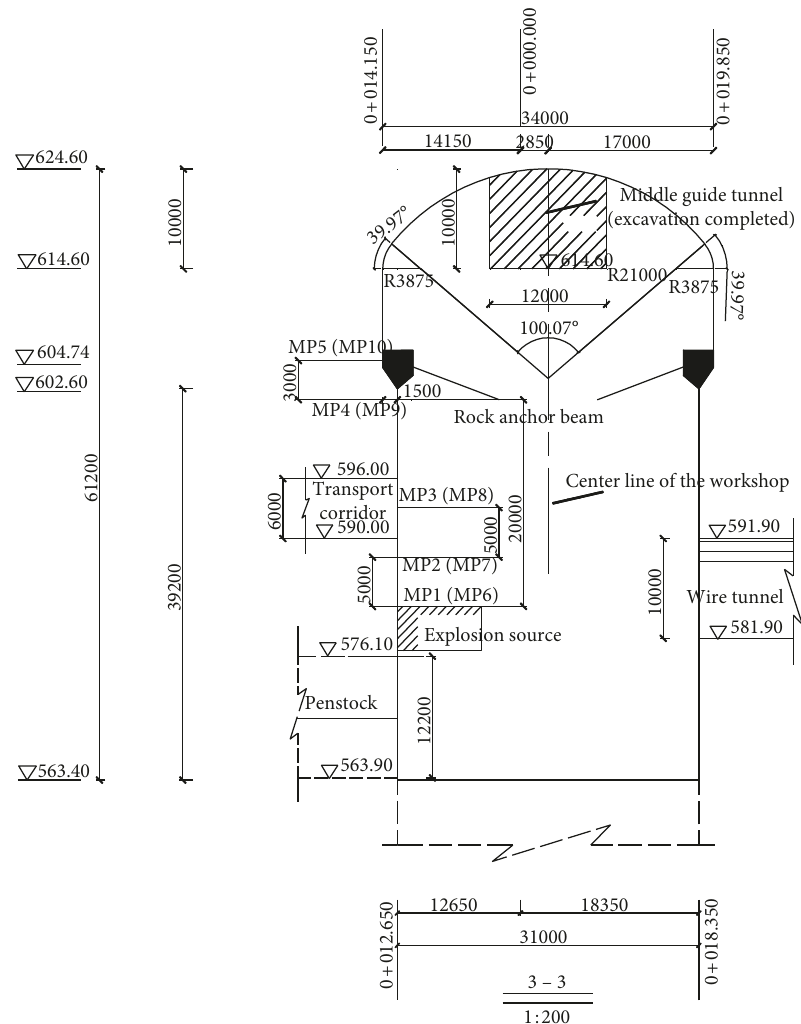
Figure 3: Front view and the dimensions of the underground powerhouse of the hydropower station (unit: